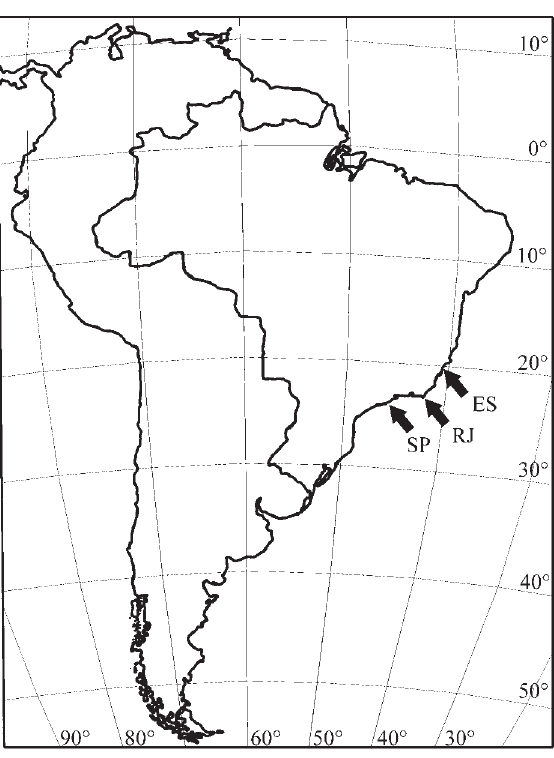
Figure 1 - Collecting sites: ES - Nova Almeida in Espírito Santo (20°03’ S 40°11’ W); RJ - Cabo Frio in Rio de Janeiro (22°57’ S 42°02’ W); SP - Ubatuba in São Paulo (23°26’ S 45°04’ W).